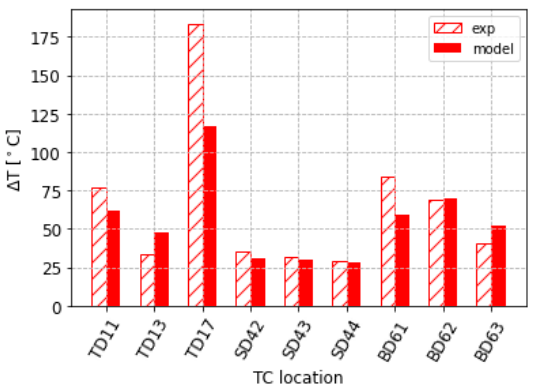
Figure 12. Time average temperature difference between production and non-production conditions for the in-process derived data and model predictions in Die-A.